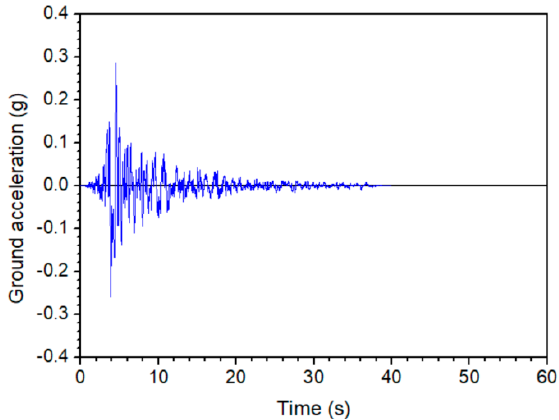
Figure 14. Time history of ground acceleration (Loma Prieta earthquake, 18 / 10 / 1989).